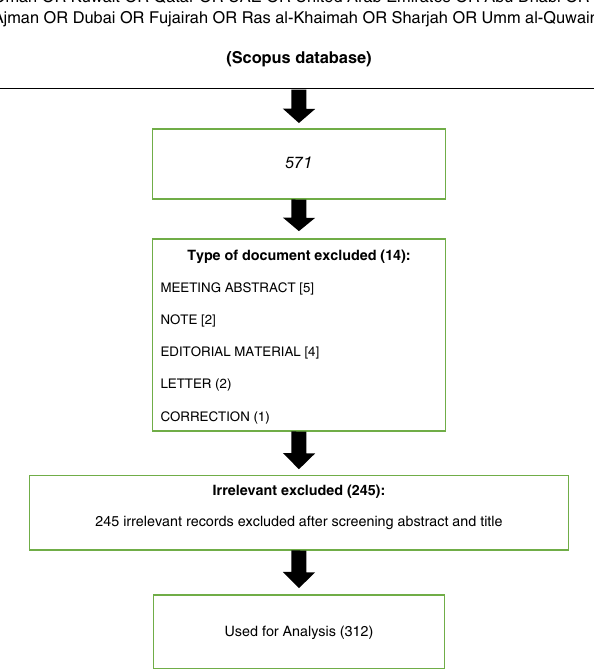
Figure 2. Flow Diagram for Literature Searching